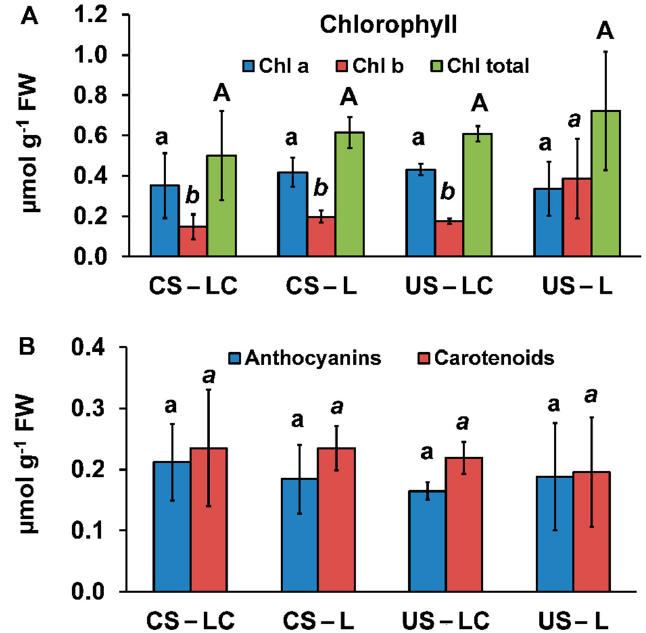
Figure 4. Aspect of soil-plant sets (US-LC, US-L, CS-LC, CS-L) after 35 days growing. (US: contaminated soil from São Domingos. US: uncontaminated soil from Caldeirão. L: seeds from Caldeirão area (non-contaminated). LC: seeds from São Domingos area (contaminated).